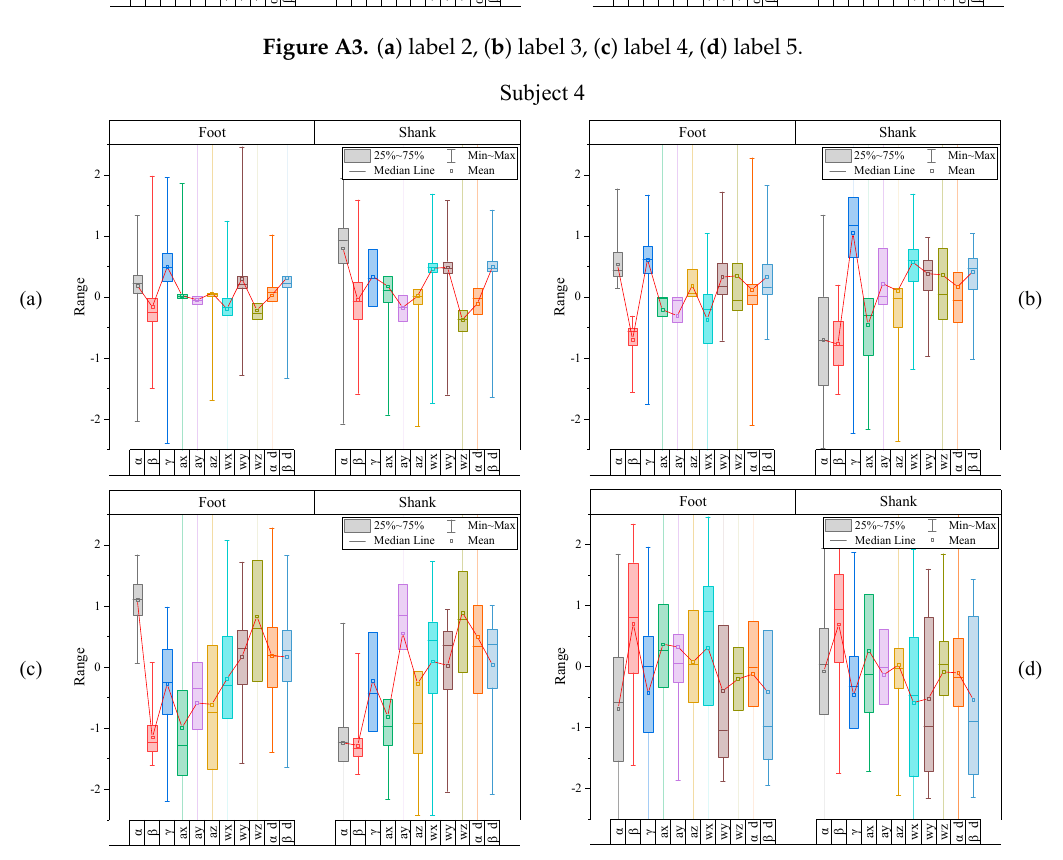
Figure A4. ( a ) label 2, ( b ) label 3, ( c ) label 4, ( d ) label 5.